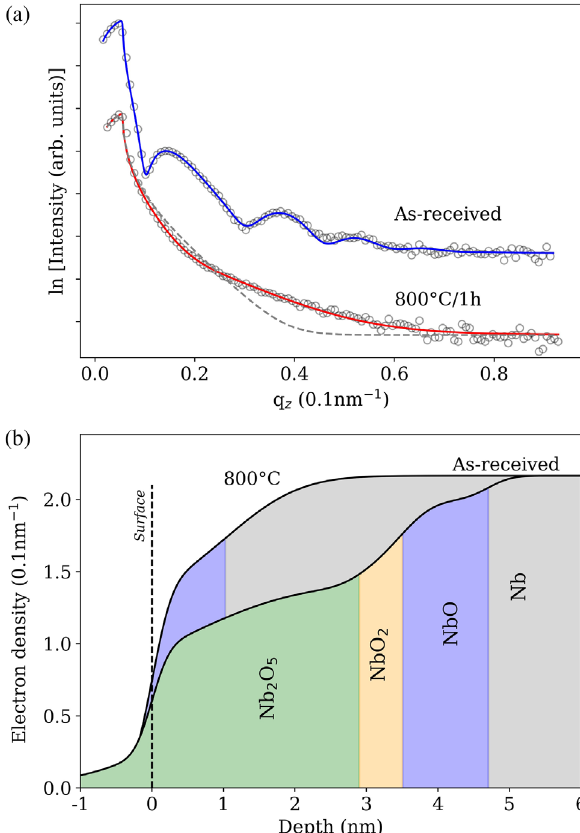
FIG. 2. (a) X-ray reflectivity data measured with Mo K α radiation (open circles) with respective fits (solid lines) for a Nb(100) single crystal as received and after 800 °C annealing in UHV for 1 h. The dashed line represents the simulated curve for a Nb surface without any surface oxide and with a constant background. The scans are offset in the y direction for better visibility. (b) Electron-density profiles for both sets of data obtained from the fits.